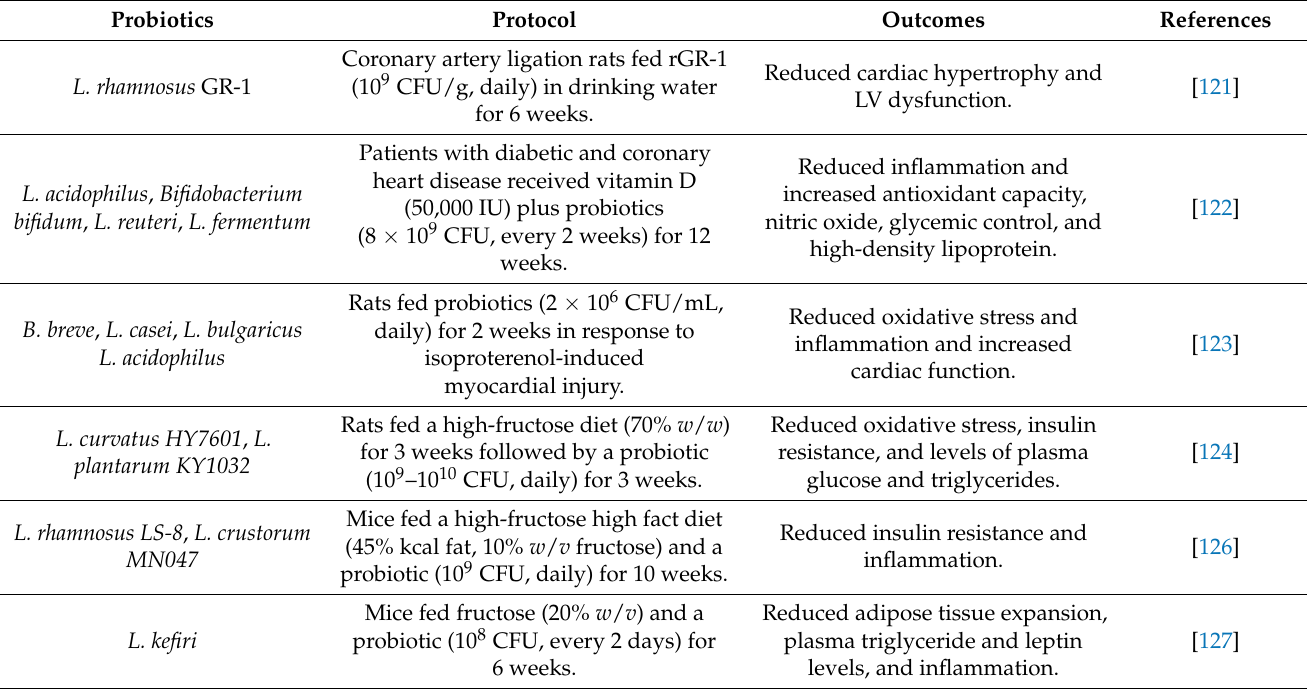
Table 1. Therapeutic effects of probiotics on cardiovascular diseases.